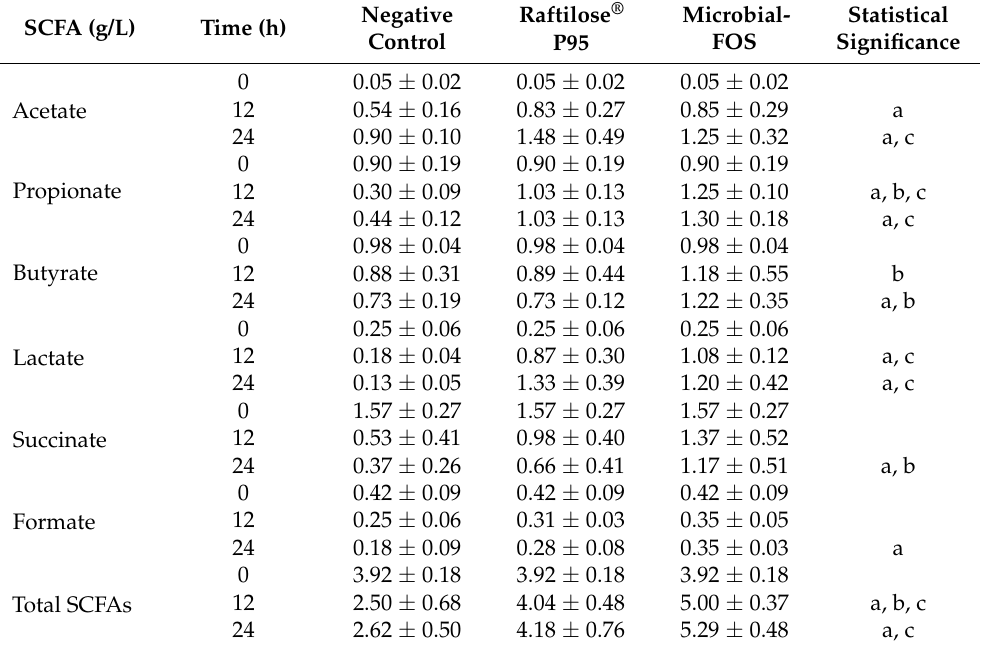
a, b, c: Statistically significant differences ( p < 0.05) between a—Microbial-FOS and negative control; b—Microbial- FOS and Raftilose ® P95; c—Raftilose ® P95 and negative